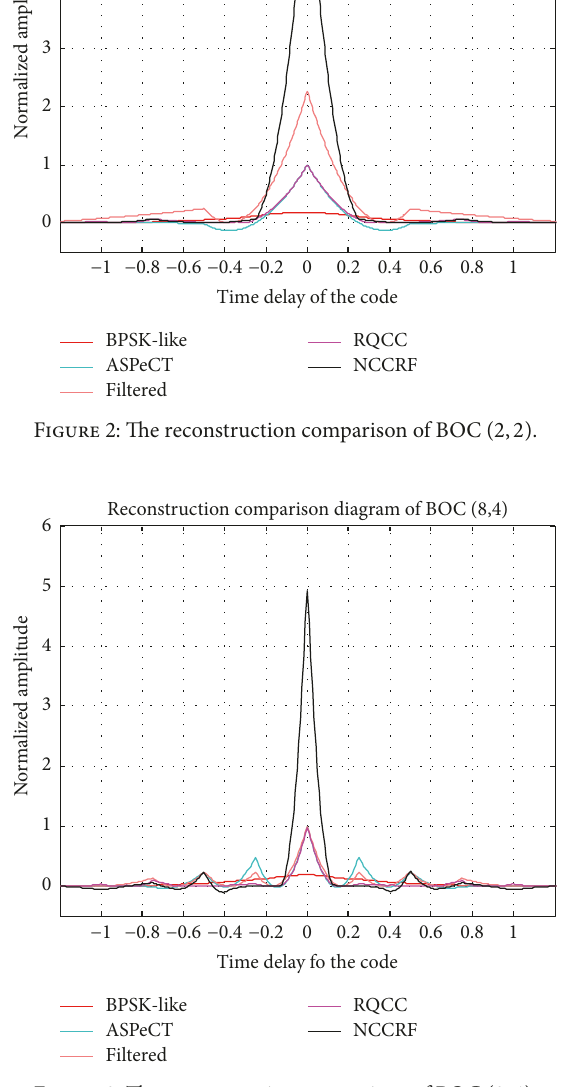
Figure 3: The reconstruction comparison of BOC ( 8, 4 ).